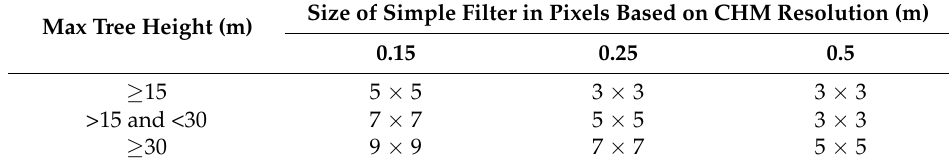
Table 4. Simple low-pass filter sizes for pit-free CHMs.